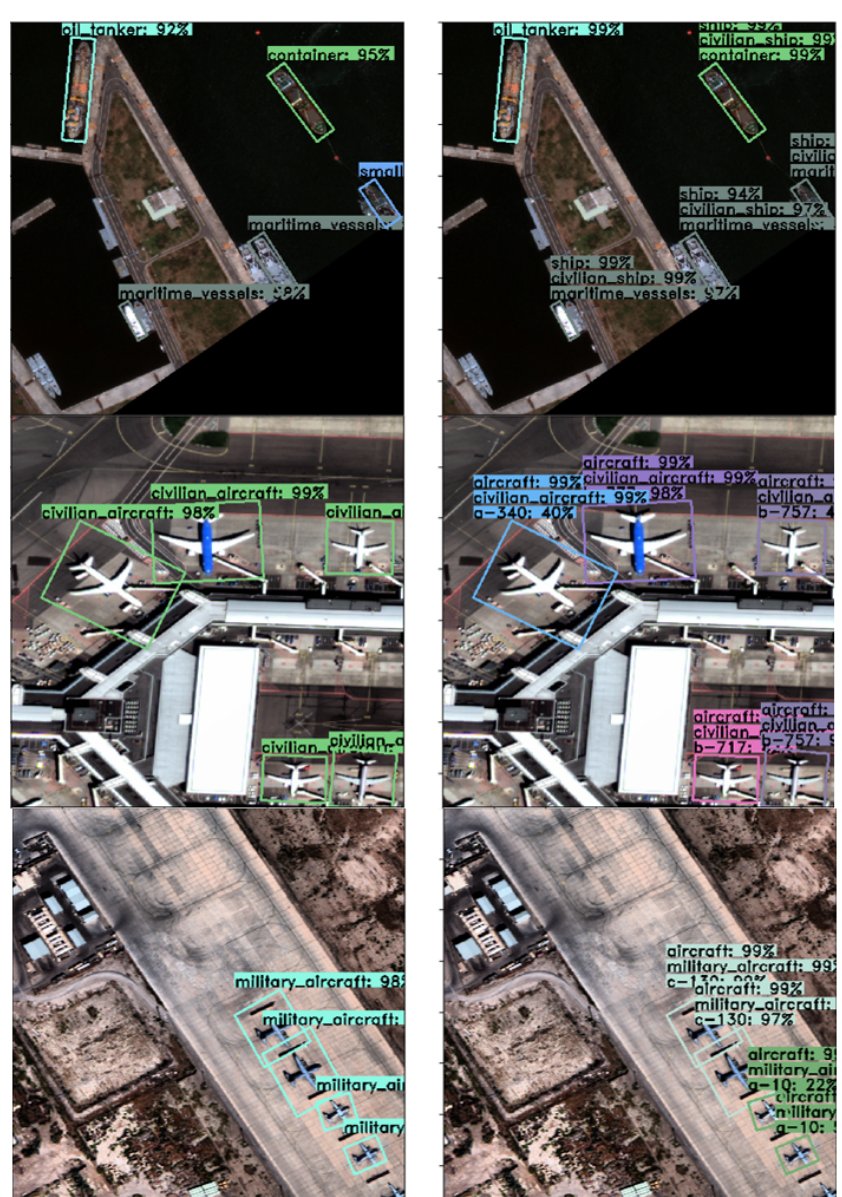
Figure 11. Comparison on the test WorldView-3 images between baseline and our proposed approach. Left column : detection results of only RBox-CNN (baseline); Right column : detection results of RBox-CNN+DHCR (ours), which shows substantial improvement in overall confidence scores and detects objects with hierarchical multi-labels. These WorldView-3 images are provided by DigitalGlobe